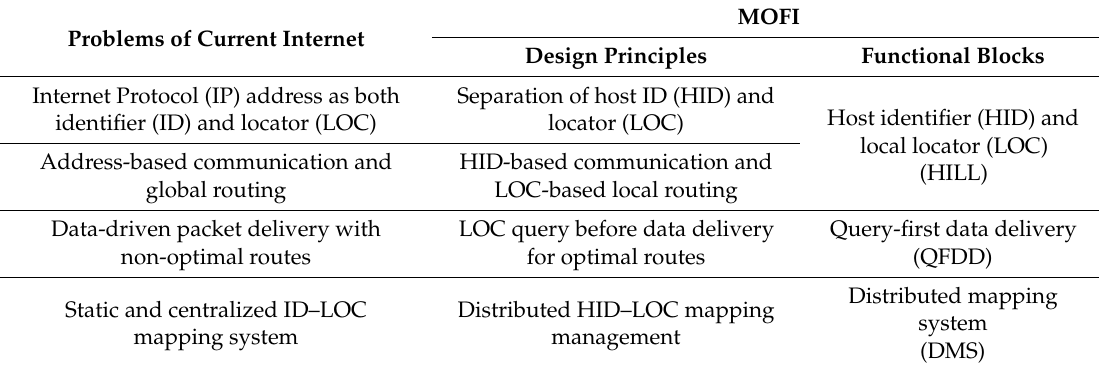
Table 1. Internet problems versus Mobile-Oriented Future Internet (MOFI) design